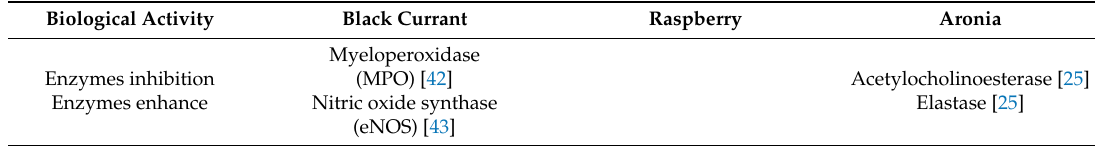
Table 3. Biological activity of extracts from black currant, raspberry, and aronia